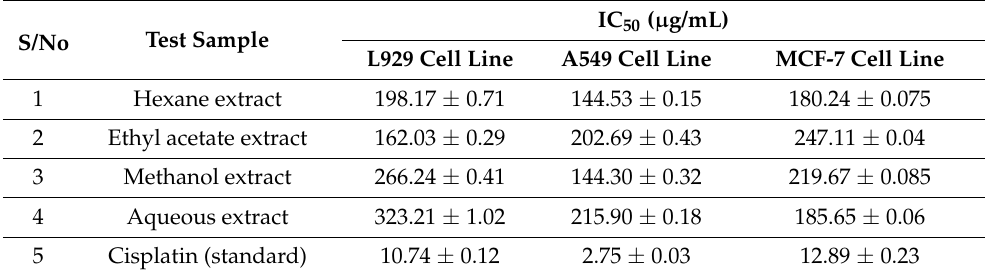
Table 4. IC 50 values of different solvent extracts of B. hochstetteri against different cell lines.